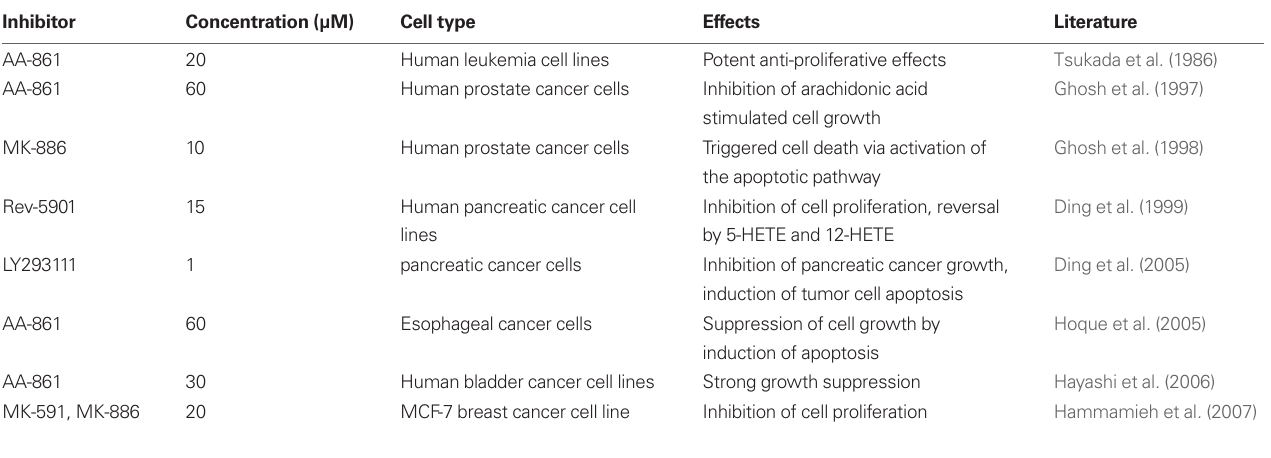
Table 1 | Cytotoxic and anti-proliferative effects by 5-LO inhibitors in cell culture assays. inhibitor Concentration (μM) Cell type Human leukemia cell lines